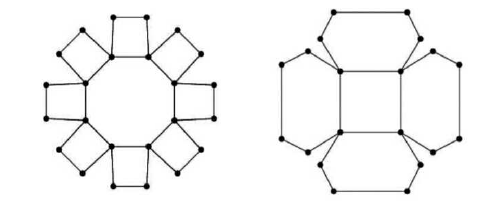
Fig. 1 Flower Graphs f 8 × 4 and f 4 ×